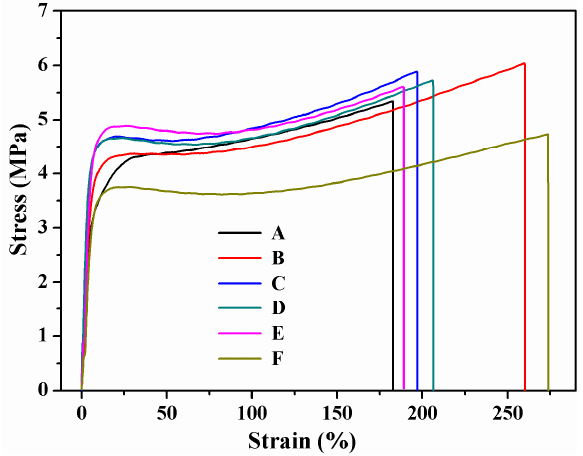
Figure 7. Stress–strain curves of different SPI-based films.